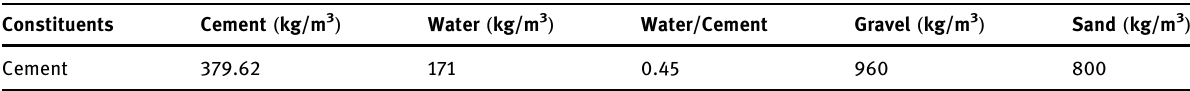
Table 2: The mixing pattern of concrete with Portland cement II